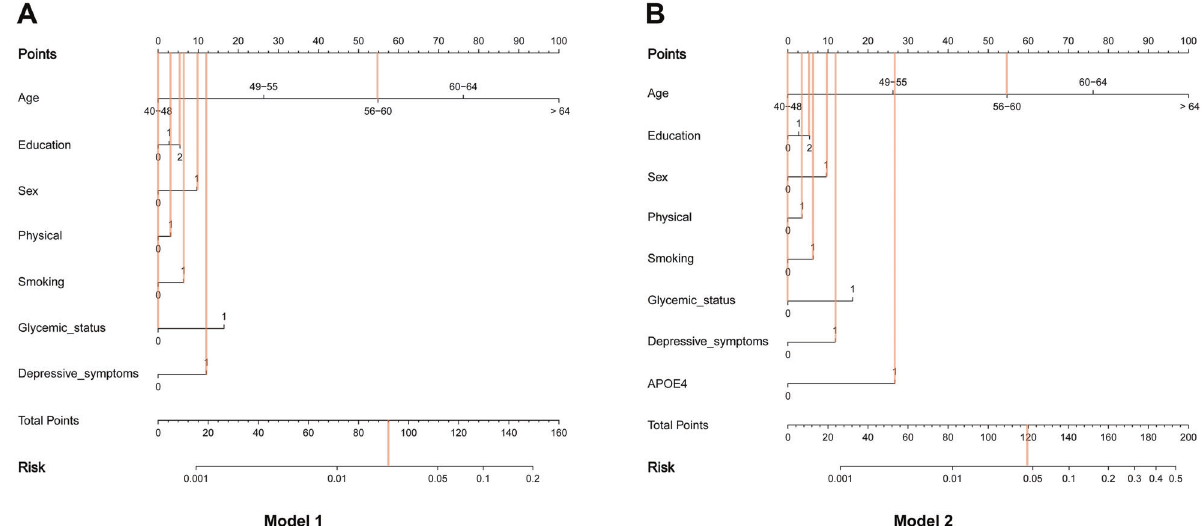
Fig. 1 Nomogram models for the prediction of developing dementia. The value of each of variable was given a score on the point scale axis. A total score could be easily calculated by adding each single score. Corresponding markers for the total dementia risk scores and probability of dementia were shown in the nomograms. The probability of dementia increased as the dementia risk score increases. The patient was 59- years old men, and with low education, had low physical activity, in the current smoking status, had normal fasting blood glucose level ( ≤ 11.1 mmol/L), had depressive symptoms, and. carrying the ε 4 alleles. Red lines are drawn upward to determine the points received by each variable; the sum (92 in model 1 ( A ), 119 in model 2 ( B )) of these points is located on the Total Points axis, and a line is drawn downward to the risk axes to determine the probability of dementia (3.0% in model 1, 4.7% in model 2). APOE4 apolipoprotein E4.